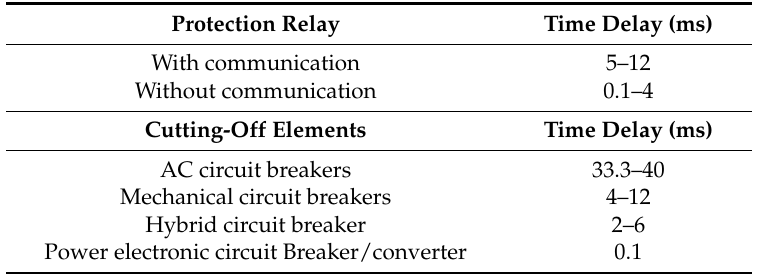
Table 1. Time delays in protection relays and methods of fault current